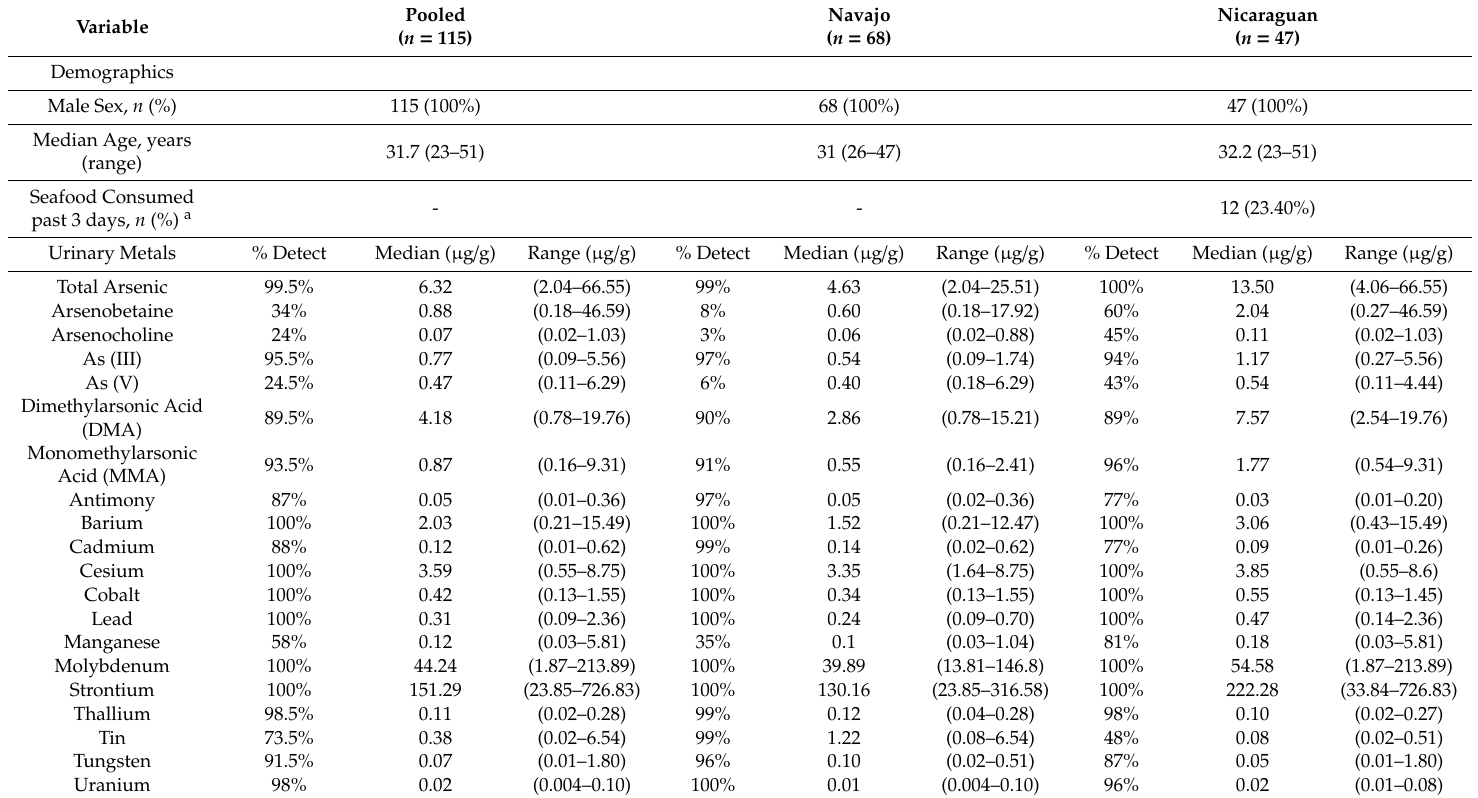
Table 1. Demographics and urinary metals detection and concentrations ( µ g / g creatinine) among the study